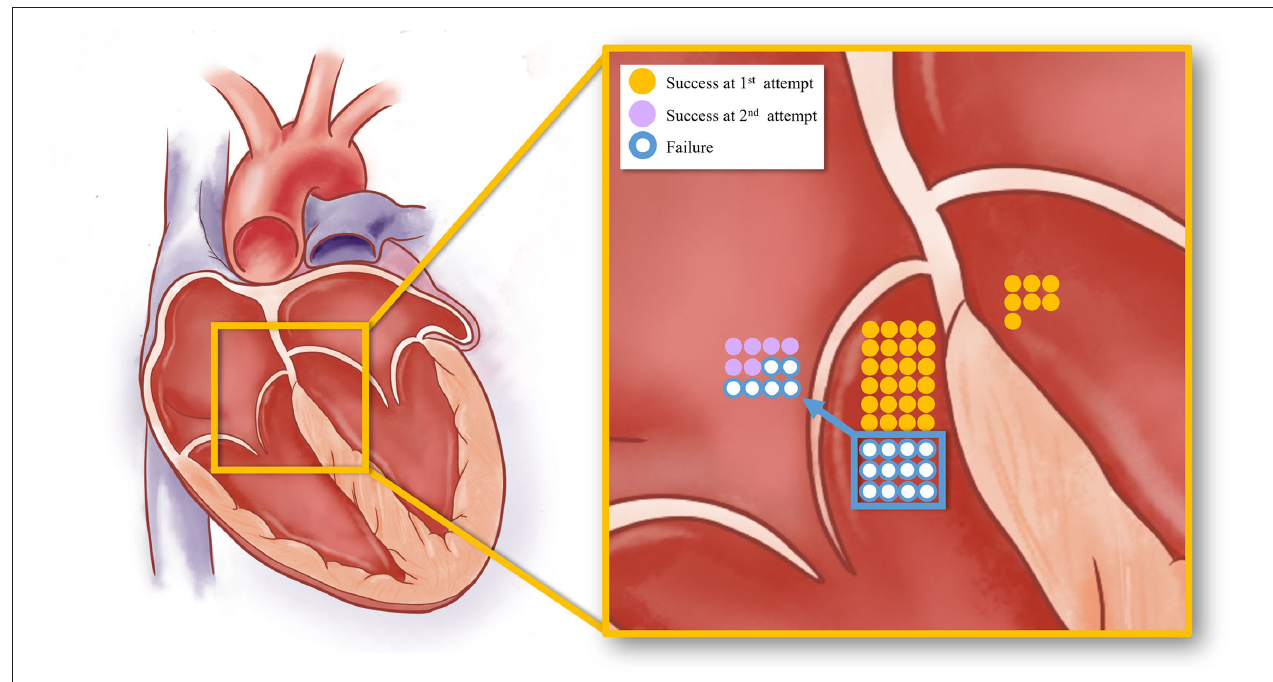
FIGURE 5 | The schematic diagram showing the acute procedural results of right and left PHVA ablation. The yellow dots represented successful cases by the B-SLTV approach and those by trans-aortic retrograde ablation. The purple dots represented success cases by the adjunctive A-SLTV approach. White dots represented cases with ablation failure.